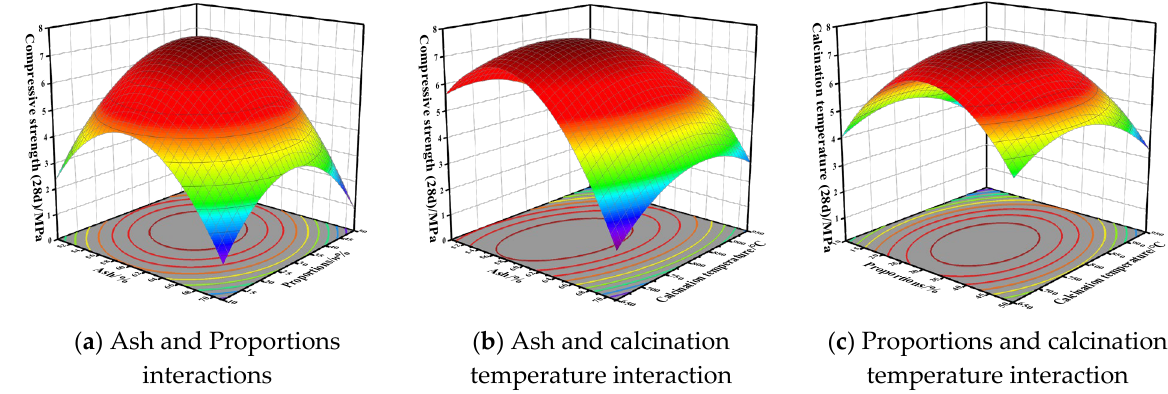
( c ) Proportions and calcination temperature interaction Figure 7. Effect of the interaction of factors on the compressive strength of CFTFM.